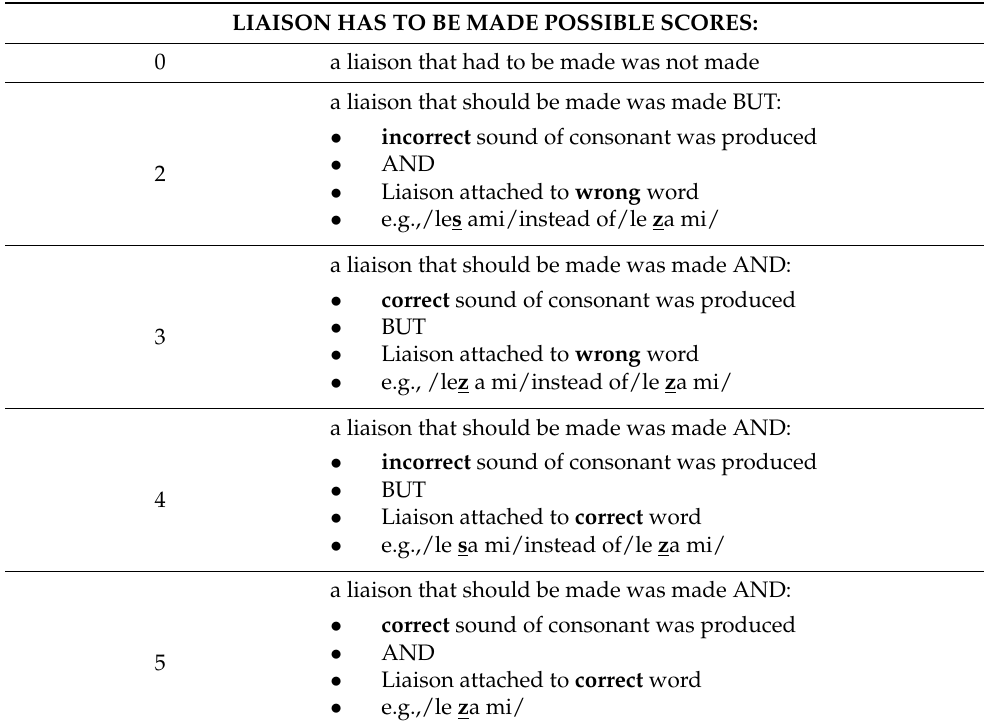
Table 3. Rating instruction for